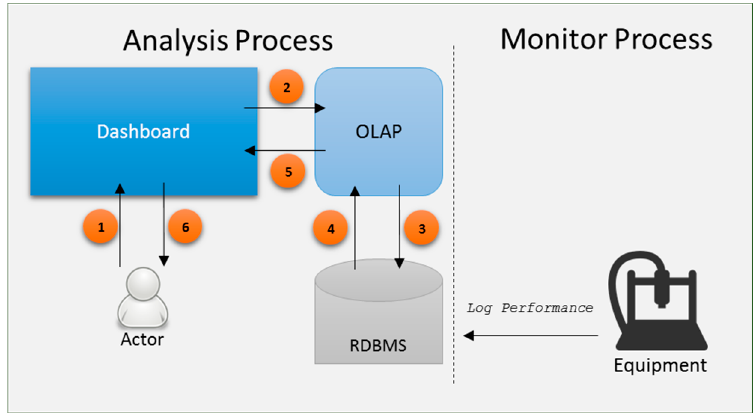
Figure 6. Application architecture.